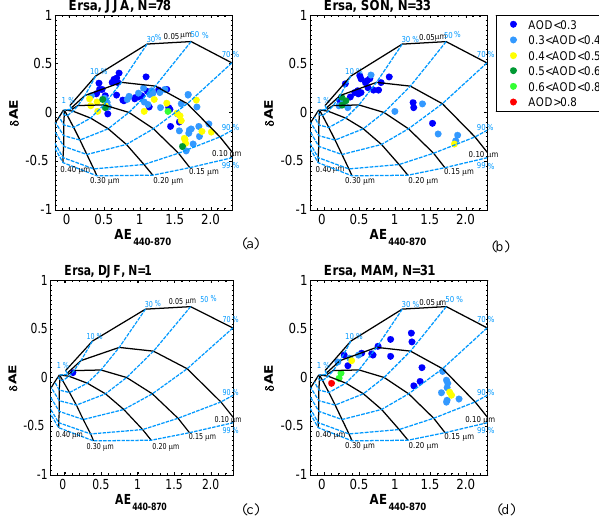
Figure 5. Ångström exponent difference ( δ AE = AE 440 − 675 – AE 675 − 870 ) as a function of the Ångström exponent calculated between 440 and 870nm (AE 440 − 870 ) at Palma during (a) sum- mer, (b) autumn, (c) winter and (d) spring, for the whole 2011– 2015 AERONET level 2.0 daily AOD dataset. Only points with AOD 675 >0.15 are represented. However, the AOD plotted is AOD 440 (and not AOD 675 ) in order to be directly comparable with the AERONET inversion criteria based on AOD 440 . The legend ap- plies for all plots. A bimodal, lognormal size distribution and a re- fractive index of 1.4–0.001 i are considered to construct the grid. The black solid lines are each for a fixed fine-mode radius and the dashed blue lines for a fixed fraction of the fine-mode contribution to the AOD at 675nm. ence between the summer mean values of AE (higher at Ersa than at Palma; 1.41 vs. 1.10) and δ AE (lower at Ersa than at Palma; 0.06 vs. 0.29) given in Table 1 reflects the gen- eral trends found from Figs. 4a and 5a. In autumn the fre- quency of moderate to large AOD events reduces by half at both sites compared to summer. Both fine- and